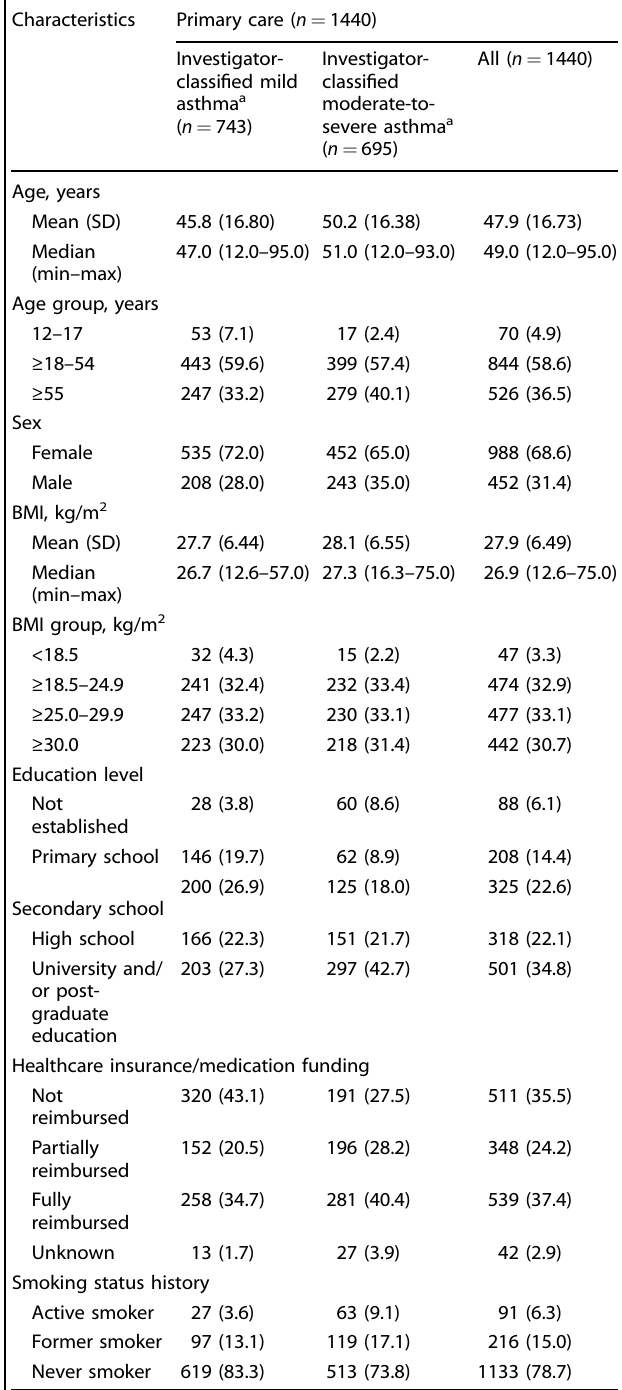
Table 1. Demographics and baseline clinical characteristics of the SABINA III PCP population by investigator-classi fi ed asthma